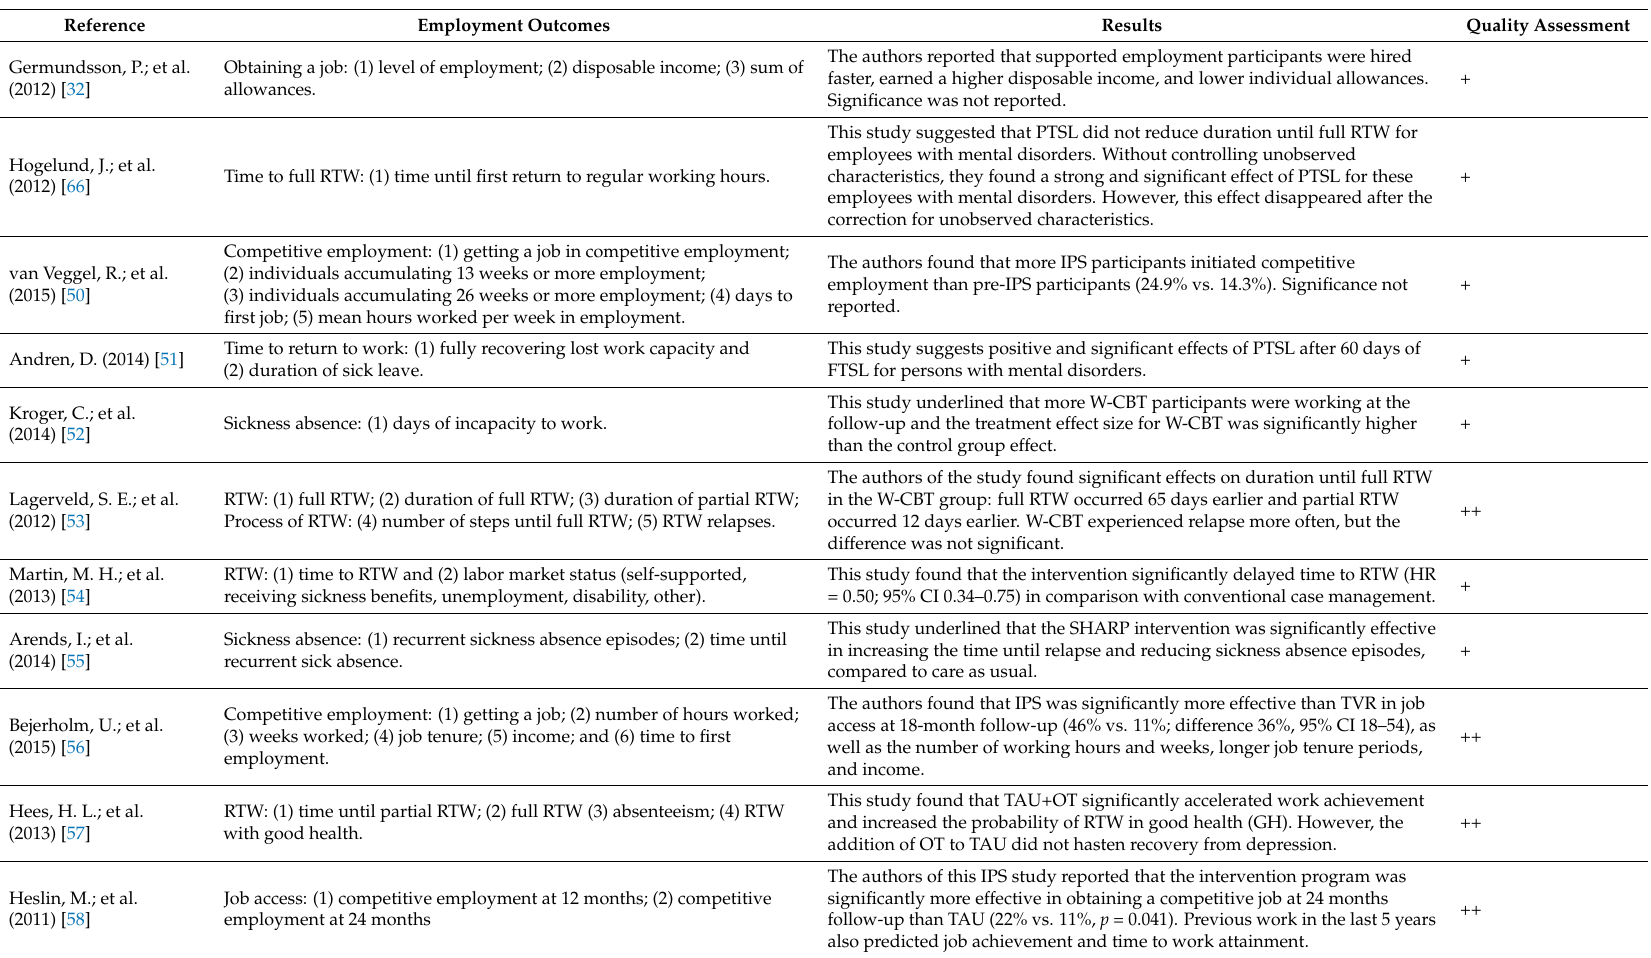
Table 2. Employment outcomes list, results, and references of the included review